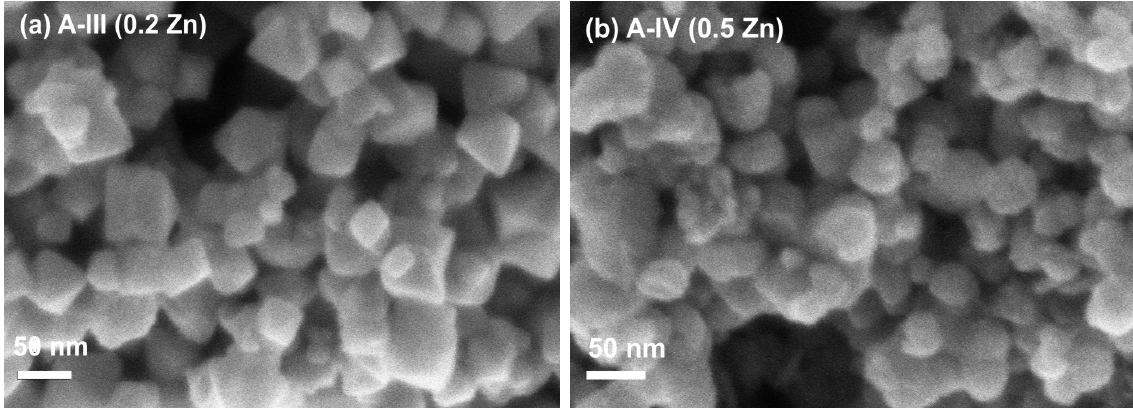
Fe O ) ( a ) and sample A-IV(Zn 0.2 2.8 4